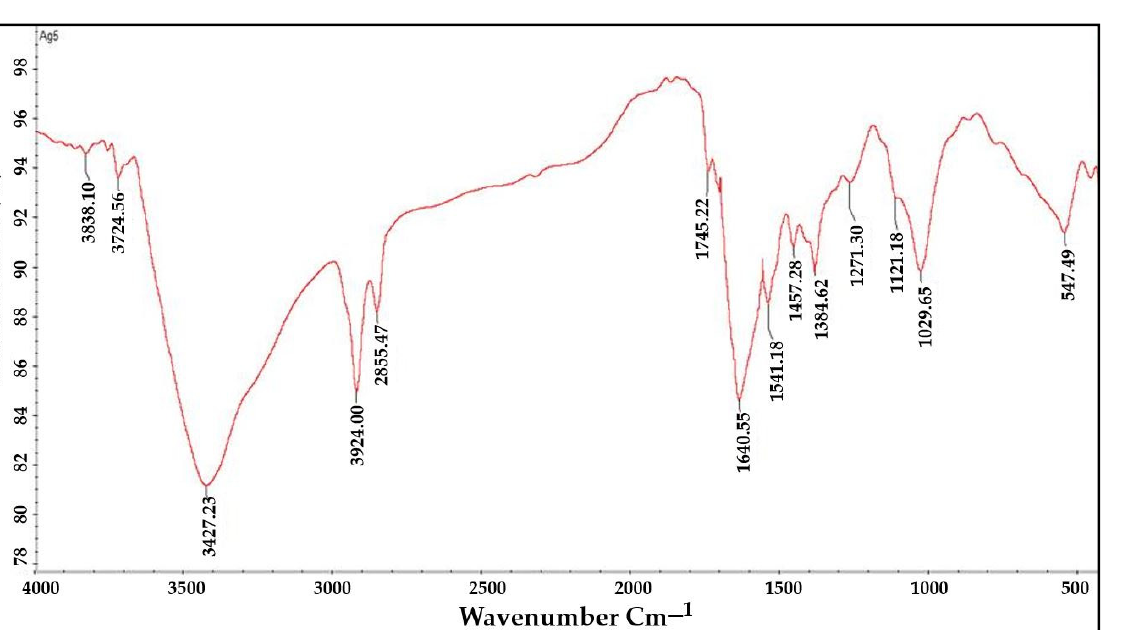
Figure 6. FTIR analyses of AgNPs synthesized from aqueous leaf extract of R. apiculata to determine functional groups responsible for the bioreduction .